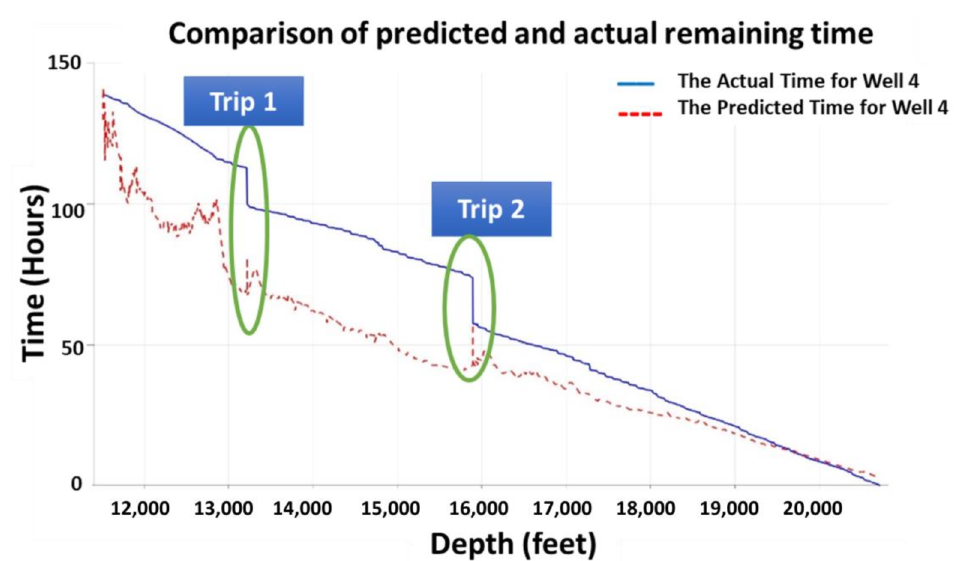
Figure 12. Comparison of the predicted and actual remaining times to TD versus drilled hole depth.